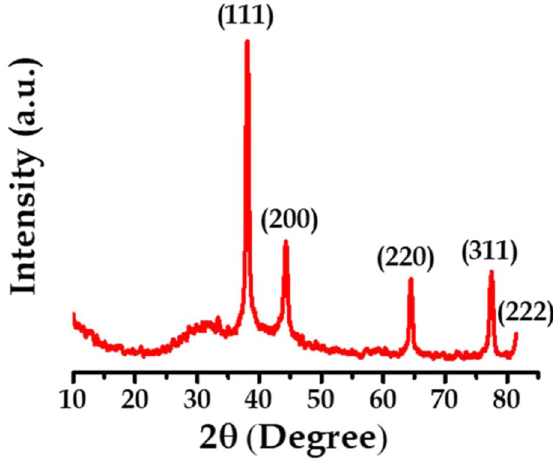
Figure 2. XRD pattern of Ag